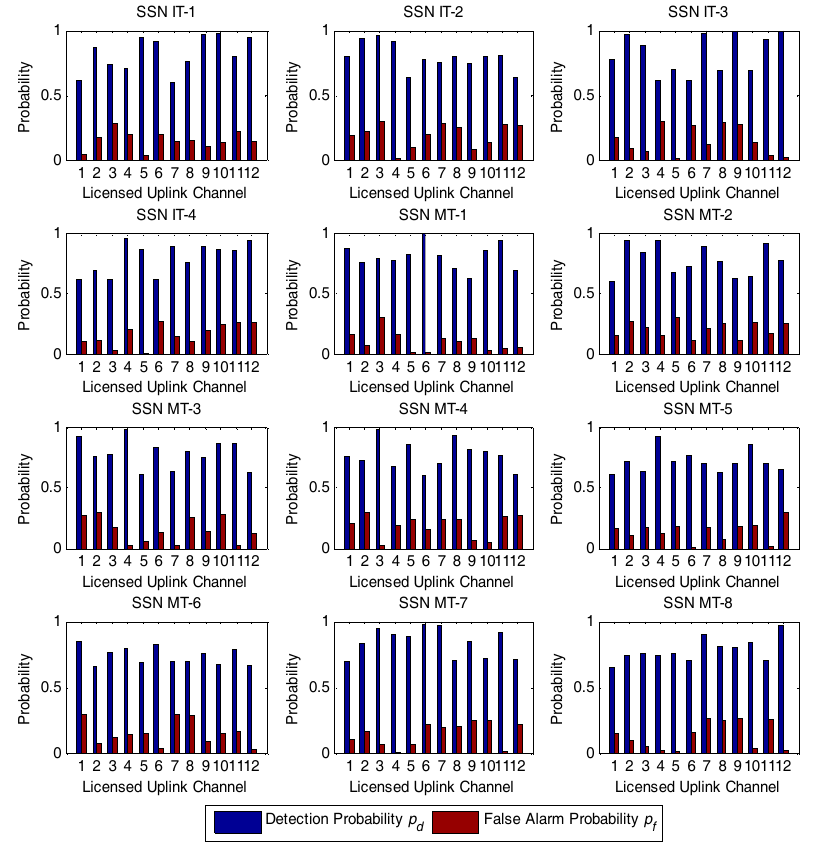
Figure 6. The detection and false alarm probabilities for spectrum sensor nodes from interior tier and middle tier over 12 uplink channels. IT: interior tier; MT: middle tier; SSN: spectrum sensor node.